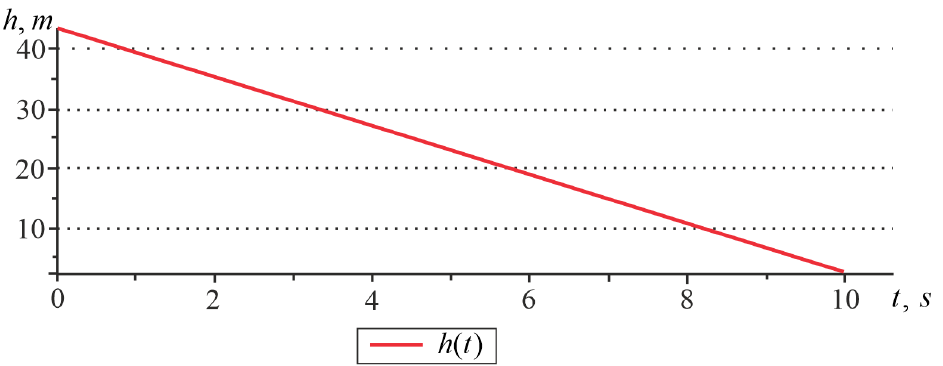
Figure 15. The height while a helicopter is landing.